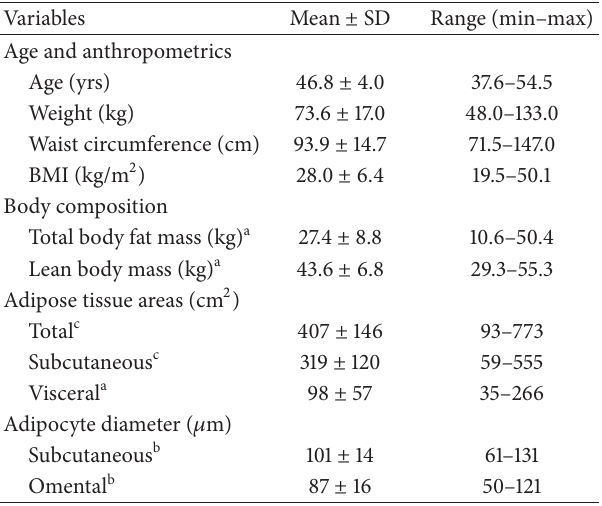
Figure 2: Omental and subcutaneous adipose tissue mRNA expres- sion of several transcripts coding for PG receptors or enzymes involved in PG synthesis in women ( 𝑛 = 46 ). Expression levels relative to ATP5O mRNA abundance are shown. PLA2G4 (phos- pholipase A2), PLA2G16 (phospholipase A2), PTGS1 (cyclooxy- genase 1), PTGS2 (cyclooxygenase 2), AKR1B1 (PGF synthase), PTGFR(prostaglandinFPreceptor),PTGIS(PGIsynthase),PTGDS (PGD synthase), PTGES, PTGES2, and PTGES3 (PGE synthase), and PTGER1, PTGER2, PTGER3, and PTGER4 (prostaglandin E receptors). Mean ± SEM are shown. AU: arbitrary units ∗ 𝑃 ≤ 0.05